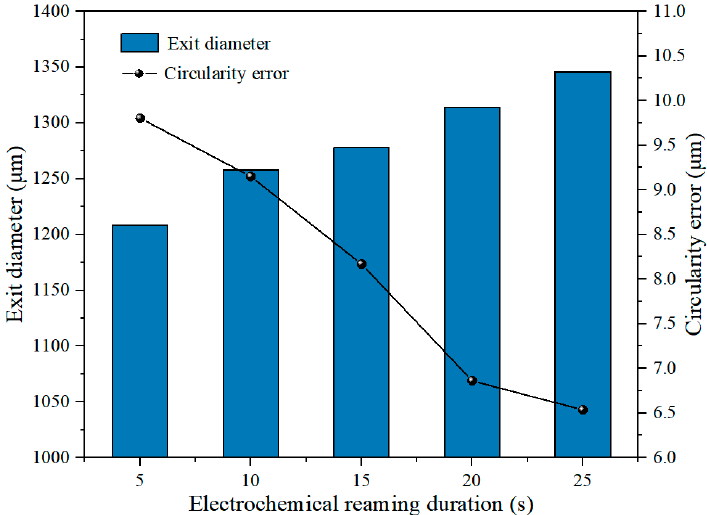
Figure 19. E ff ect of duration of electrochemical reaming on exit diameter and circularity error.